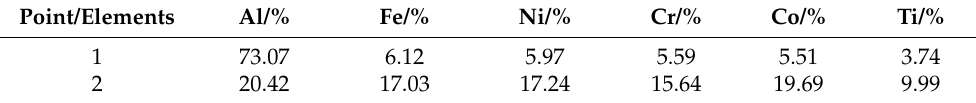
Figure 6. EDS dotted spectrum of 10 vol.% HEA composites. Table 4. Elemental analysis results of 10 vol.% HEA composites by EDS (at. %, atom fraction). Point/Elements